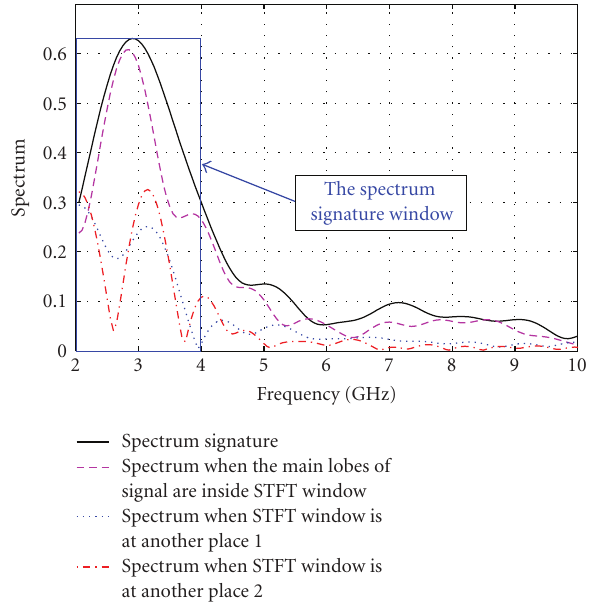
Figure 7: The di ff erent spectrums when the STFT window slides through the target signal. The solid black line presents the spectrum